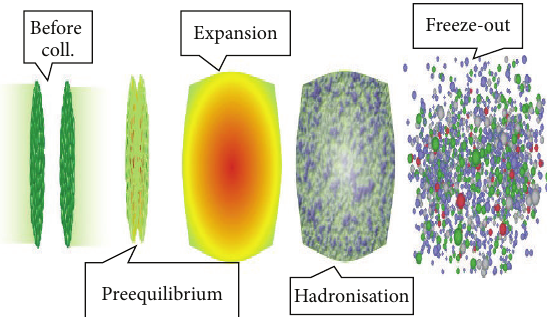
Figure 1: Different stages of nuclear collisions at ultrarelativistic